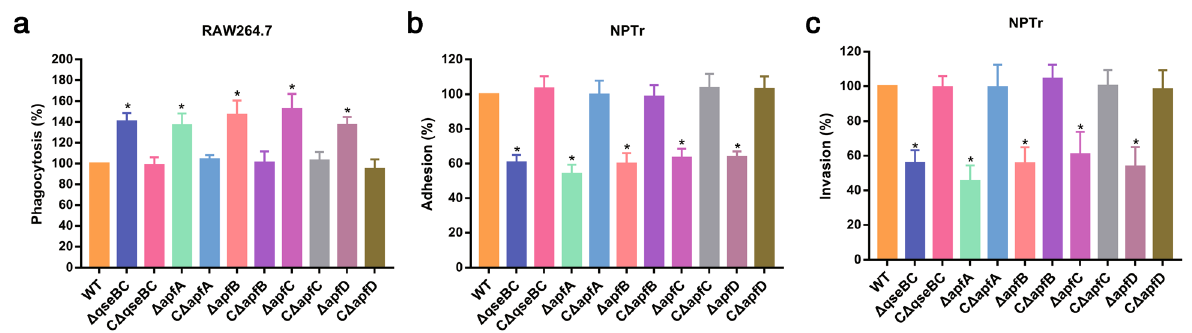
Fig. 6 Cell phagocytosis, adhesion and invasion assays. a Phagocytosis of Δ qseBC , Δ apfA , Δ apfB , Δ apfC and Δ apfD strains. The strains were incubated with RAW264.7 cells at the multiplicity of infection (MOI) of 100 at 37 °C for 2 h. b , c Adhesion ( b ) and invasion ( c ) of Δ qseBC , Δ apfA , Δ apfB , Δ apfC and Δ apfD strains. The strains were incubated with NPTr cells at the MOI of 100 for 2 h of incubation at 37 °C. After washing out the unbound bacteria, the NPTr cells were lysed and the bacterial counts in the lysates were determined. Data are shown as mean ± SD ( N = 3). * P <